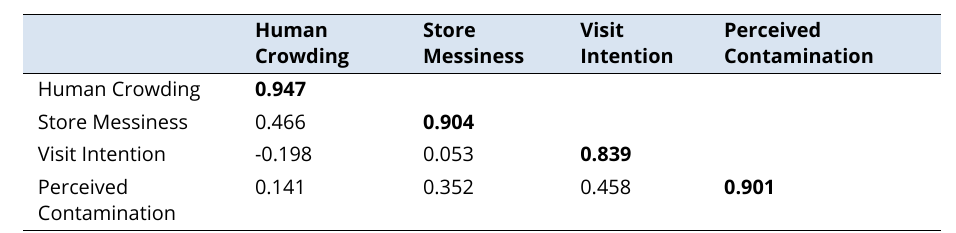
Fornell and Larcker